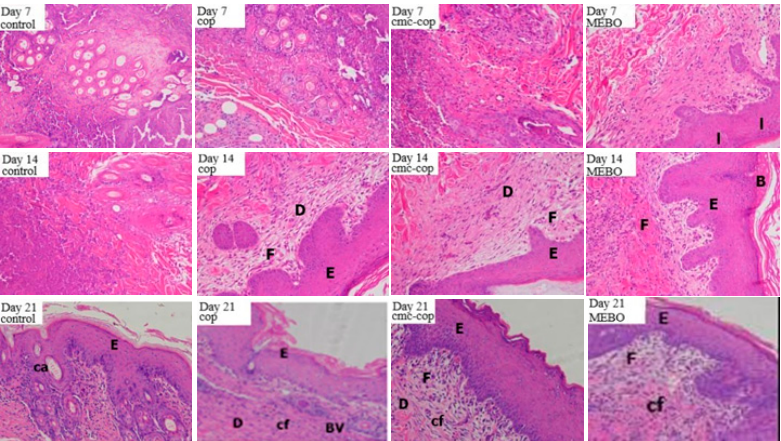
Figure 8. Micrographs of wound tissues in rabbits (H&E, 200 × ). Note: F, fibroblast; E, epidermis; D, dermis; Cf, collagen fiber; BV, blood vessel; Ca, cutaneous appendage; I, inflammatory; B, blister.